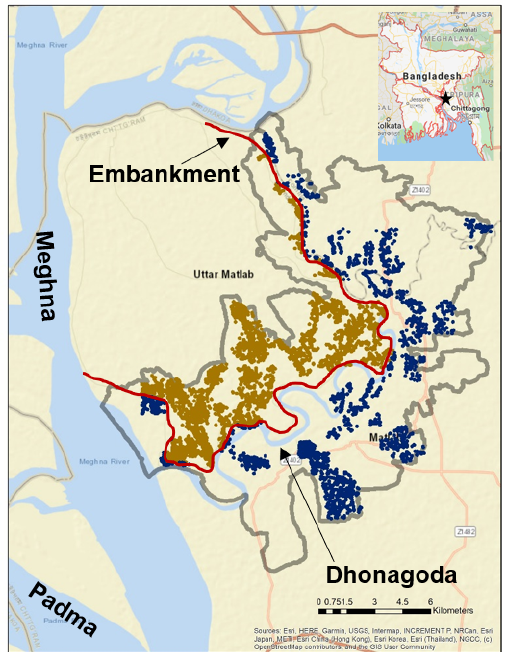
Figure 1. Baris (cluster of households) are colored based on whether they are located inside (brown) or outside (blue) the embankment